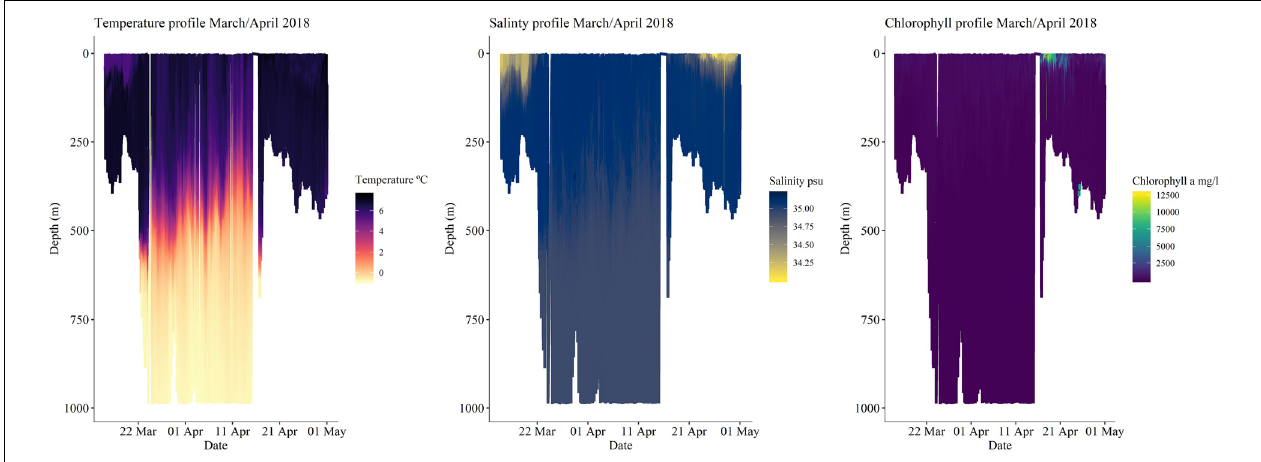
FIGURE 4 | Environmental conditions throughout Seaglider TM